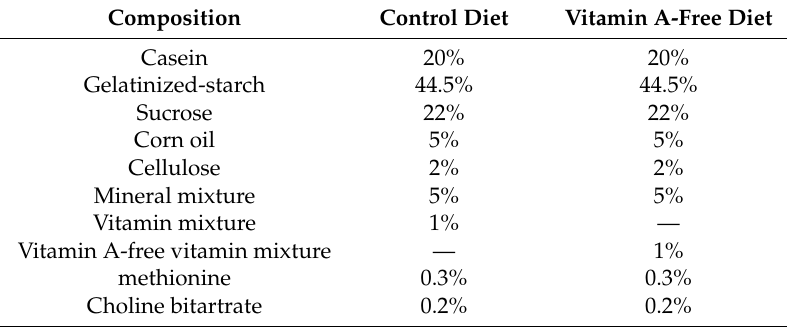
Table 4. The composition of the rat diets (%).